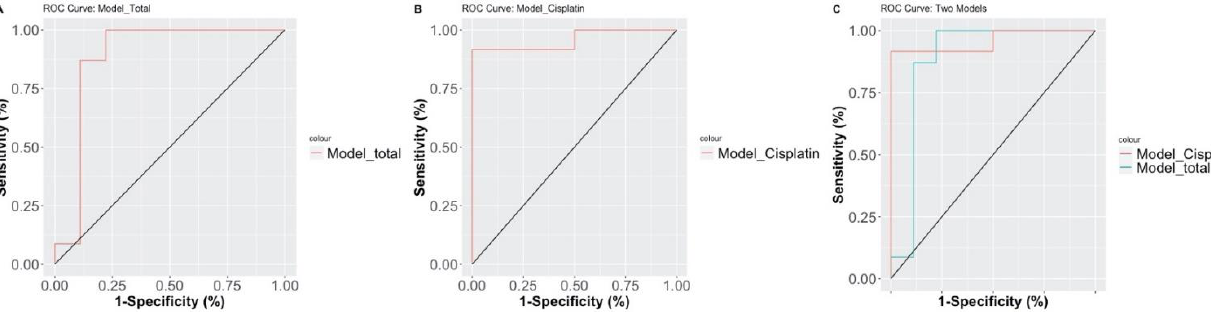
Figure 4. Receiver operating characteristic curves of marker combinations for clinical outcome prediction through eSelect screening as grouped by different data sets. ( A ) Model_Total: a prediction model for the entire data set. ( B ) Model_Cisplatin: prediction model inclusive of all cisplatin-treated subjects; ( C ) Combine Model_Cisplatin and Model_Total.